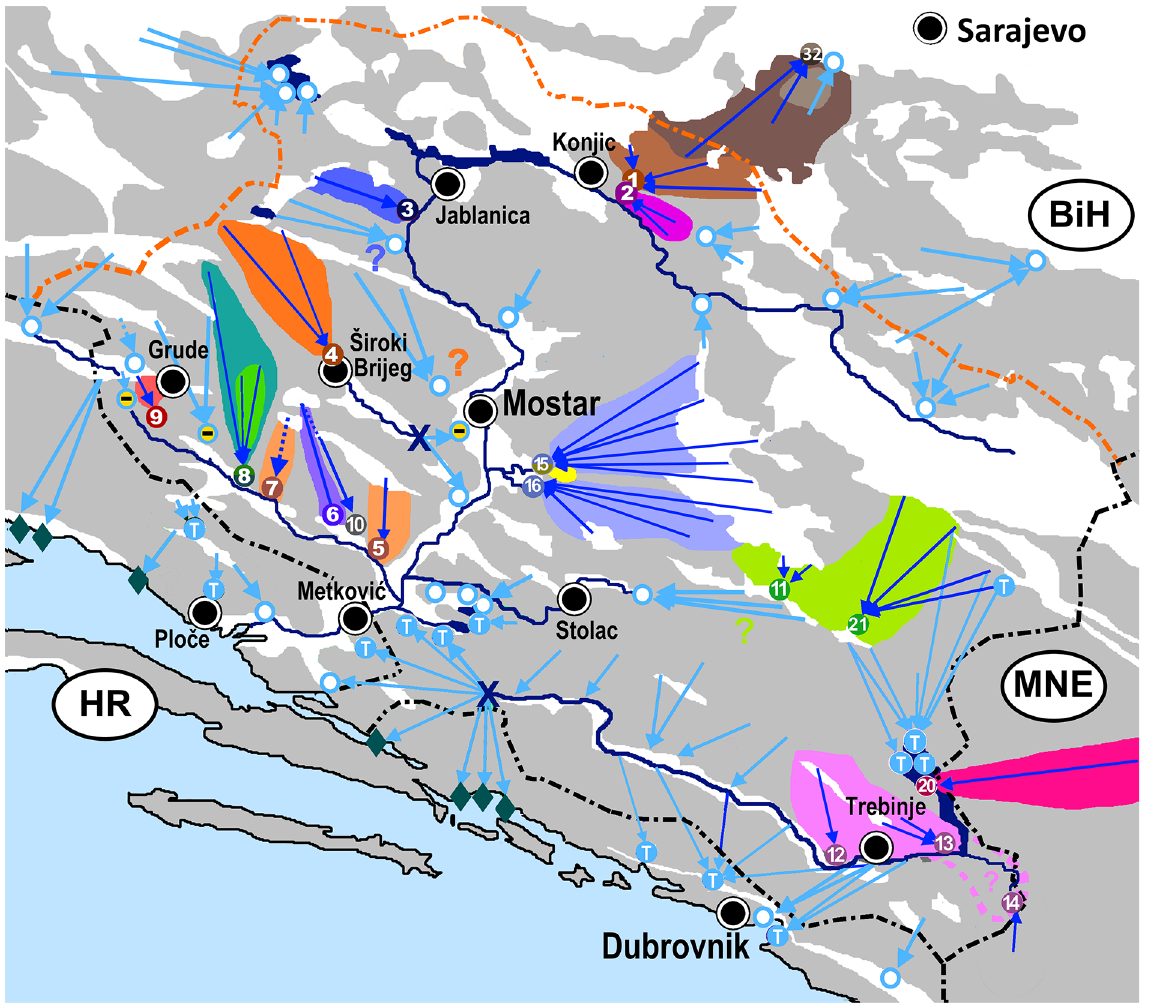
Fig. 18. Localities of Plagigeyeria species in Hercegovina and adjacent regions and the most likely distribution range of the known species within the related aquifers (colour blotches) and sampling localities (dots with numbers). Freshwater springs are in circles and brackish or submarine springs are as marked by diamonds, arrows show main karst conduits and locality numbers are according to the legend from Fig.